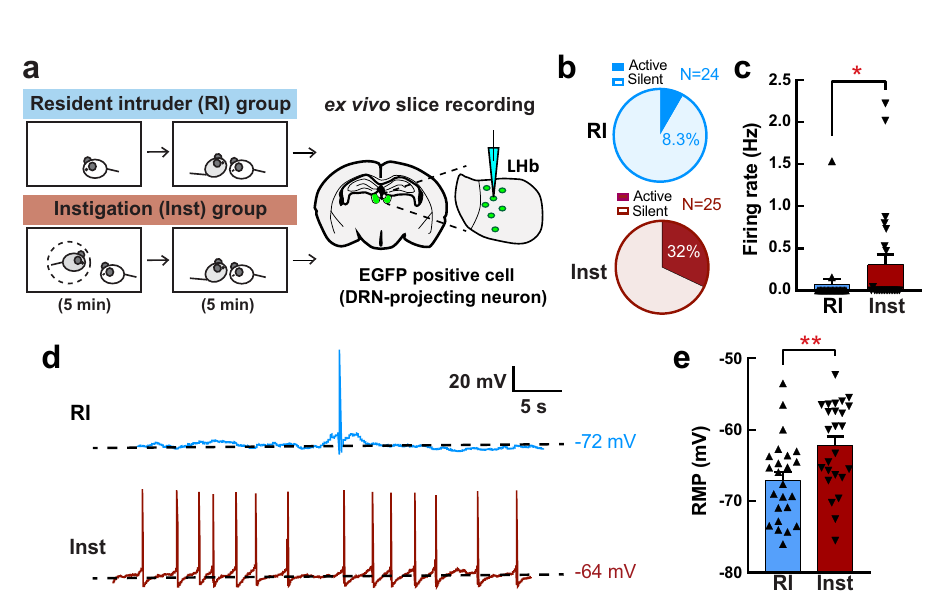
Fig. 1 Social instigation-heightened aggression and c-Fos in LHb-DRN projection neurons. a Schematics of this experiment. Test animals were injected with RetroBeads into the DRN (outlined in white lines; scale bar 400 μ m). The standard resident-intruder (RI) group was tested for 5 min during RI test. The social instigation (Inst) group had a 5 min exposure to a caged-instigator male prior to the 5 min RI test. Control (Cont) animals were kept undisturbed. b Inst group showed longer duration of aggressive behaviors compared to RI group (two-way repeated measures ANOVA, RI n = 10, Inst n = 12 biologically independent animals, main effect of Group: F(1,20) = 16.93, p = 0.0005). c Temporal pattern of occurrence of attack bites (red) and sideways threat (orange) in individual animals of RI and Inst groups. d Aggressive behaviors were increased by social instigation in the fi rst 2 min of aggressive encounter compared to RI group (two-way repeated-measures ANOVA with the Geisser-Greenhouse correction, RI group n = 10 and Inst group n = 12 biologically independent animals, Group × time interaction, F (4,80) = 9.615, p < 0.0001, post hoc t test with Bonferroni ’ s correction (two-sided)). e RetroBead + cells (red) were observed in the LHb and LH (scale bar 500 μ m). Higher magni fi cation of white-dotted square is indicated in f – h (scale bar 20 μ m). c-Fos expression (green) and RetroBead + cells (red) in the LHb of Cont ( f ), RI ( g ), and Inst ( h ) groups. Blue: DAPI (scale bar 20 μ m). Average number of c-Fos expressing cells ( i ) and RetroBead + cells ( j ) in the LHb per slice. Both RI and Inst groups showed higher number of c-Fos expressing cells in the LHb compared to Cont ( i , one-way ANOVA, Cont n = 8, RI n = 8, Inst n = 10 biologically independent animals, F (2,24) = 18.00, p < 0.0001, post hoc t test with Tukey ’ s multiple comparisons test (two-sided)). j Number of RetroBead + cells in the LHb were not different among groups ( j , one-way ANOVA, Cont n = 8, RI n = 8, Inst n = 10 biologically independent animals, n.s .). k Percent of c-Fos expressing RetroBead + cells were signi fi cantly higher in Inst group compared to Cont (Kruskal – Wallis test (two-sided), Cont n = 8, RI n = 8, Inst n = 10 biologically independent animals, Kruskal – Wallis statistic = 7.638, p = 0.0219, post hoc test with Dunn ’ s multiple comparisons test (two-sided)). Representative picture of RetroBead + cells ( l ), Vglut2 positive cells ( m ), and their overlay with DAPI ( n ) in the LHb (scale bar 20 μ m) stained by in situ hybridization. Arrowhead indicates RetroBead and Vglut2 colocalized cells. o Percent of RetroBead + cells ( n = 247 biologically independent cells) that colocalized with Vglut2 . * p < 0.05, *** p < 0.001, **** p < 0.0001. Error bars indicate standard error of the mean (SEM). Source data are provided as a Source Data fi le.